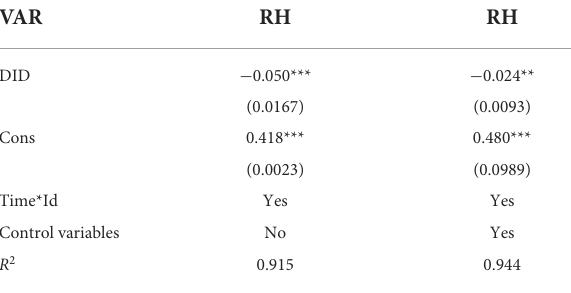
TABLE 6 Results of tailoring